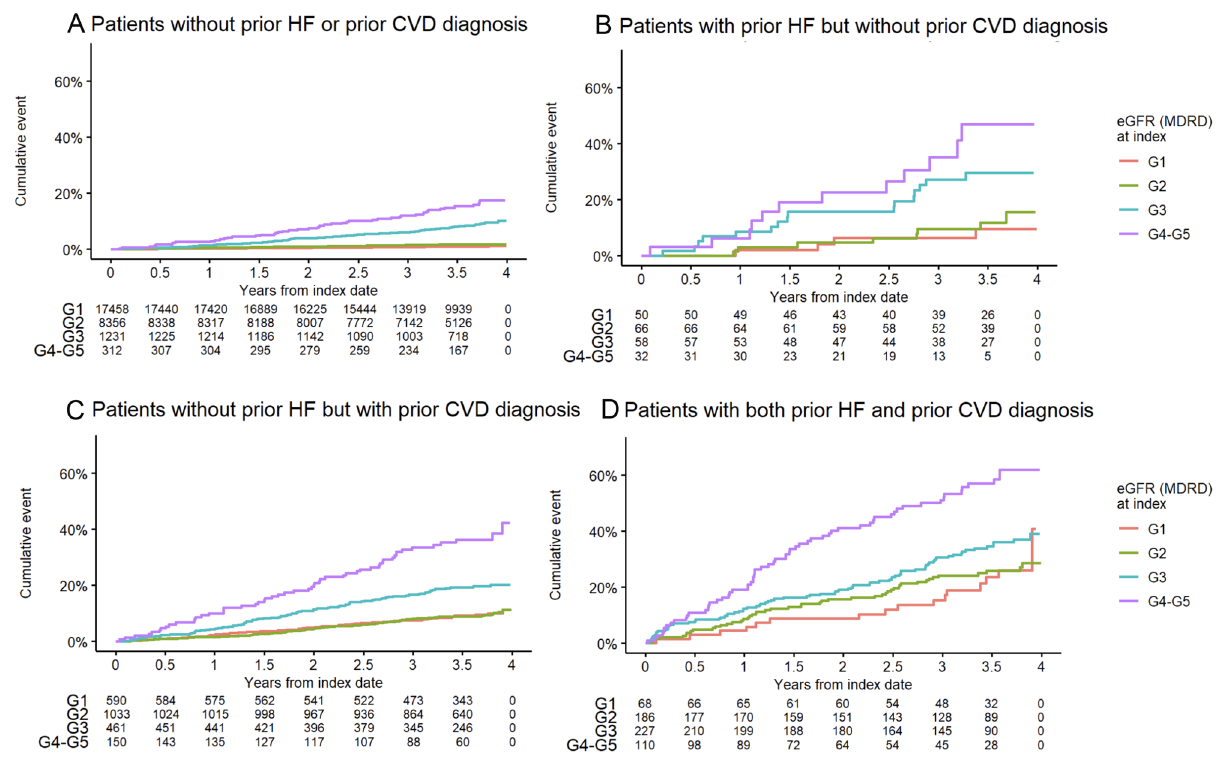
Mortality rate (number of events per 1000 person years, 95